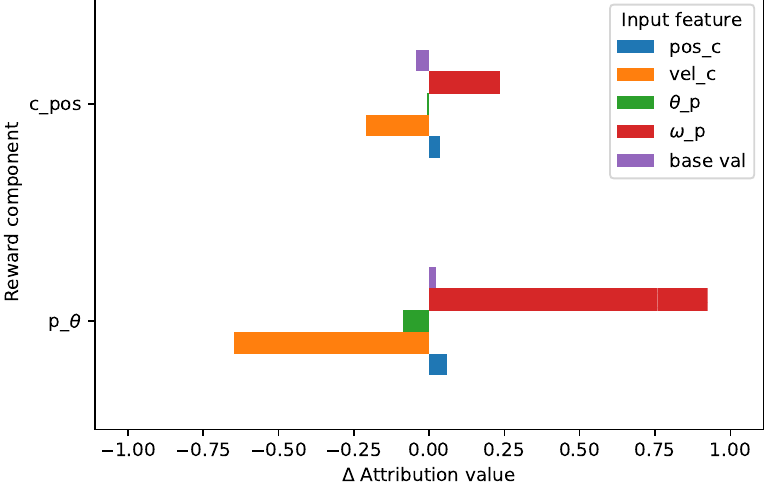
Figure A5. The contrastive explanation showing why the agent chooses push-right instead of push- left